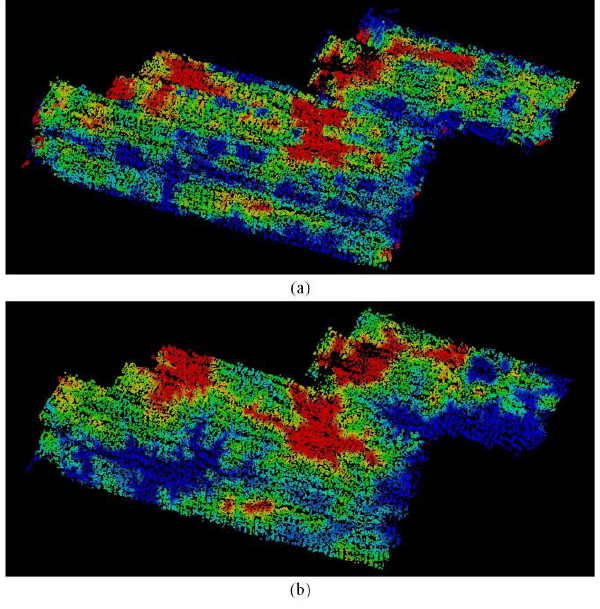
Figure 7. Point clouds. (a) and (b) show the point clouds before and after the self-calibration bundle adjustment with GPS information in Case II,